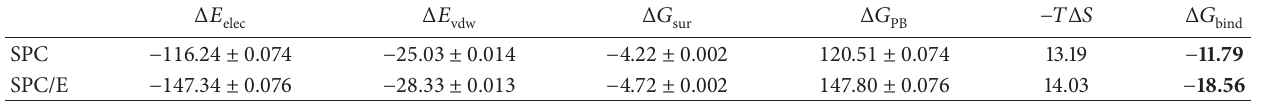
Table 6: The same as in Table 3 but for GROMOS96 43a1 force field.